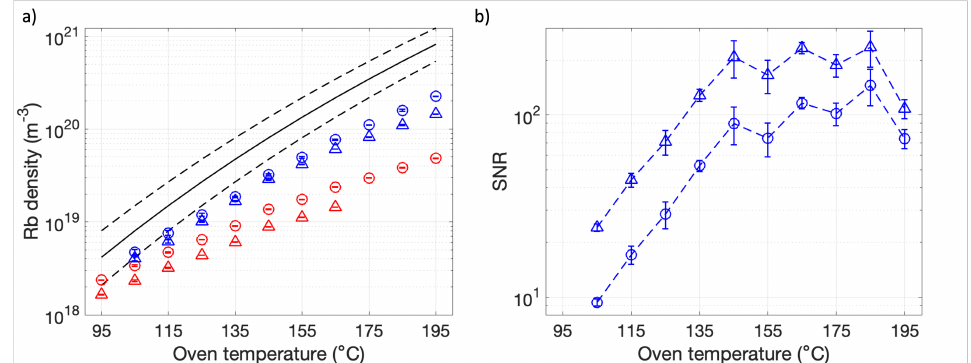
Figure 4. ( a ) Rb densities measured from the 5 S 1/2 → 6 P 1/2 (blue circles), 6 P 3/2 (blue triangles), 5 P 1/2 (D 1 ) (red circles), 5 P 3/2 (D 2 ) (red triangles) transitions vs. oven temperature, T oven . The black line is saturation Rb density, [ Rb ] sat , calculated based on T oven (see Table 1) and dashed lines indicate T oven ± 10 ◦ C. ( b ) Corresponding signal-to-noise ratio (SNR) for violet absorbance spectrum. SNR in D 1 and D 2 absorbance spectra was high ( > 100) and so was not included. Dashed blue lines are to guide the eye